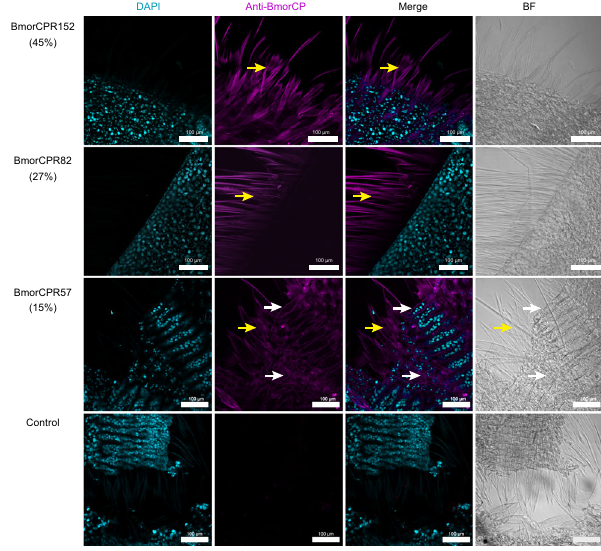
Fig. 4 Immuno-localization of His-rich CPs in the normal wing. BmorCPR152 (row 1) and BmorCPR82 (row 2) are mainly distributed on the scales. A very low signal of BmorCPR57 (row 3) was observed in both scales and wing. Control (row 4). white arrows, wing; yellow arrows, scales; turquoise, DAPI; magenta, Goat Anti-rabbit IgG /Alexa Fluor 555; BF, bright fi eld (phase contrast). The colors of images were processed with Photoshop CS software (Adobe). Scale bar = 100 μ and BmorCPR57 or were curved after reduction of BmorCPR82 ,